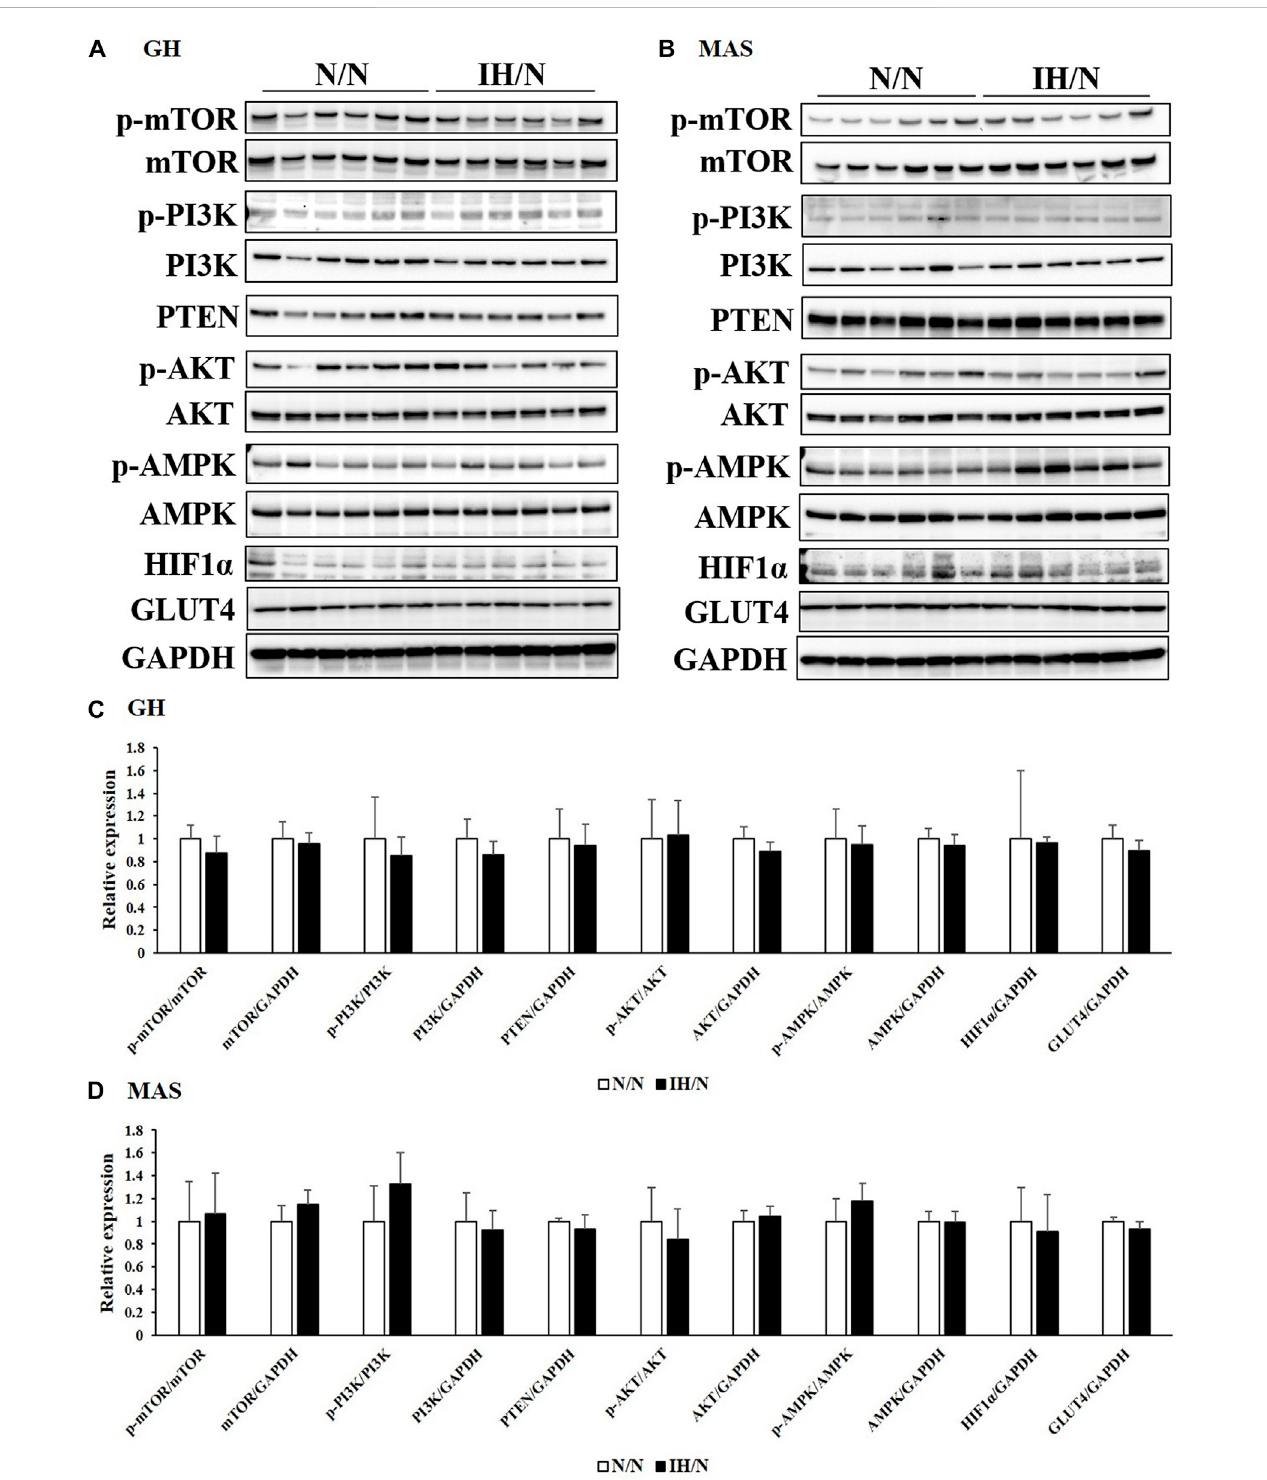
FIGURE 7 Western blot analysis of proteins involved in glucose and lipid metabolism in the GH and MAS muscles. Western blots were performed on six individual samples to quantify the levels of mTOR, PI3K, AKT, AMPK, PTEN, and HIF1 α in the (A) GH, and (B) MAS muscles. Graphs represent the ratio between the phosphorylated forms of mTOR, PI3K, AKT, and AMPK and the total amount of each target protein. Expression levels of each protein are shown relativeto the level of GAPDH expression, for the (C) GH, and (D) MAS muscles from the N/N group set to